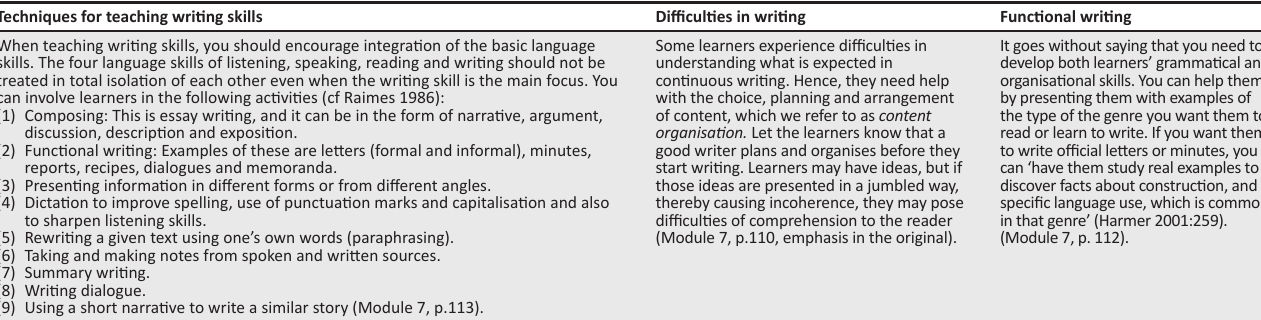
TABLE 1: Section on writing